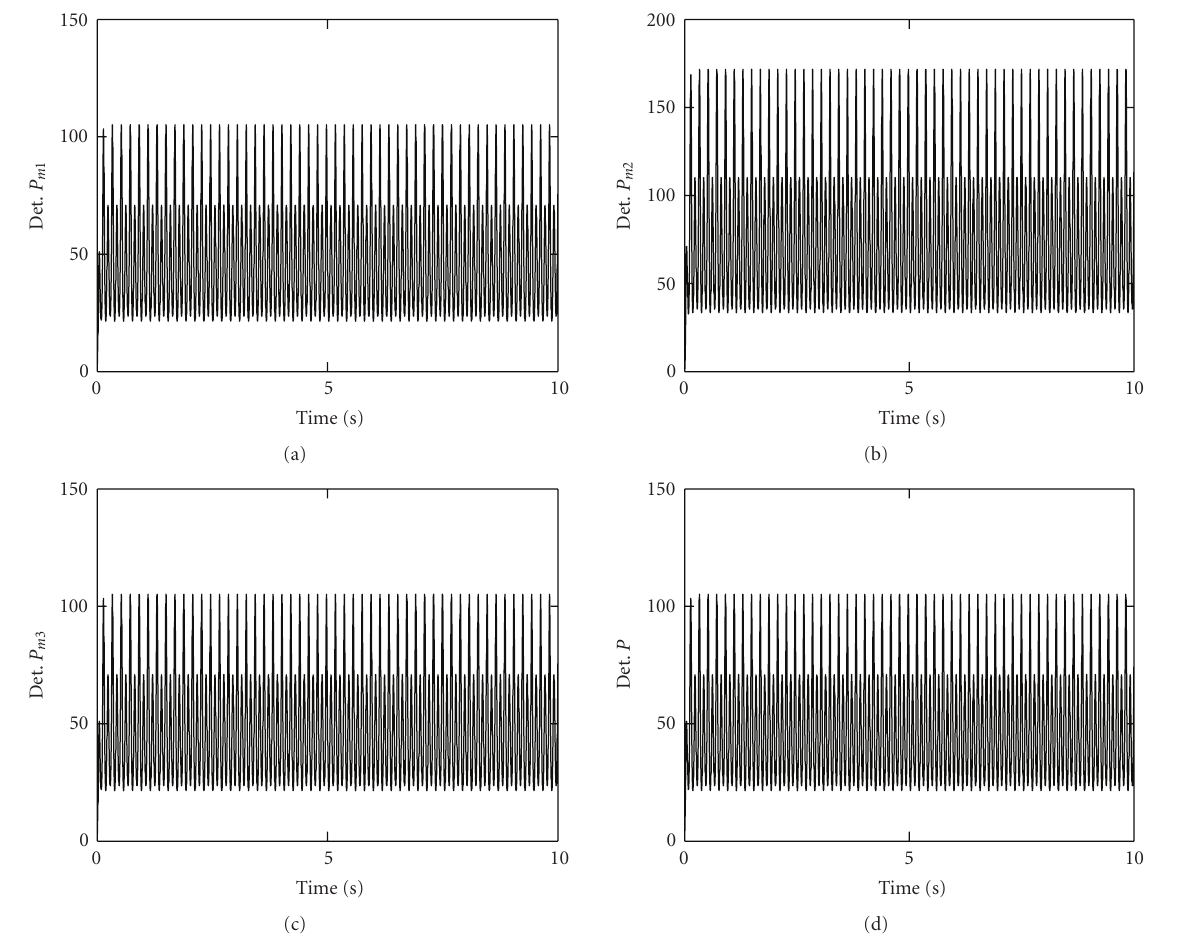
Figure 6: Time evolution of the determinants of the principal minors of the matrix P ∈ R 4 × 4 P m 1 , P m 2 , P m 3 , P m 4 .